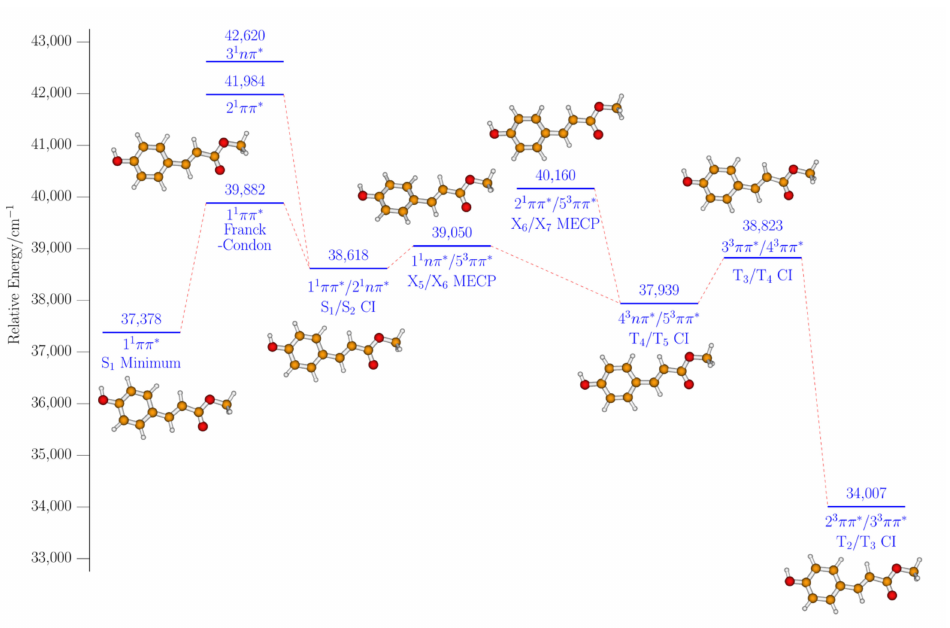
Figure 6. Energy landscape showing points relevant to the NRD of p-HMC. Geometries were optimised starting in the syn conformation. All energies are relative to the S0 state of the anti conformer Franck-Condon (FC) point. Energies, in cm − 1, are given above the blue lines; immediately below are the states in question; and below that are the labels of the optimised points. We have also included images of the molecular structures of the optimised points, above or below the lines for clarity. From left to right are the data for the S1 minimum; the FC point; the S1/S2 conical intersection (CI); the X5/X6 (S1/T5) minimum energy crossing point (MECP); the X6/X7 (S2/T5) MECP; the T4/T5 CI; the T3/T4 CI; and the T2/T3